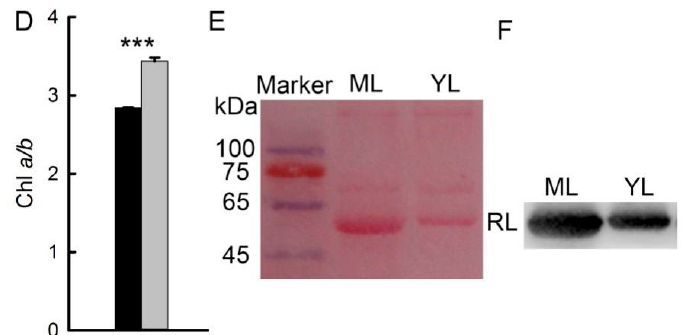
Figure 3. Contents of protein and chlorophyll. Contents of total chlorophyll (Chl) ( A ) and Rubisco ( B ) of ML and YL (n = 5). The values of Rubisco/chlorophyll ( C ) and Chl a/b ( D ) of ML and YL (n = 5). Ponceau-stained membrane before Western blot analysis ( E ) and the Western blotting analyzed Rubisco large subunit (RL) of ML and YL ( F ). The error bars represent standard errors for five biological replicates. Asterisks indicate different significant differences (** P < 0.01, *** P < 0.001) according to two-sided Student’s t -tests.